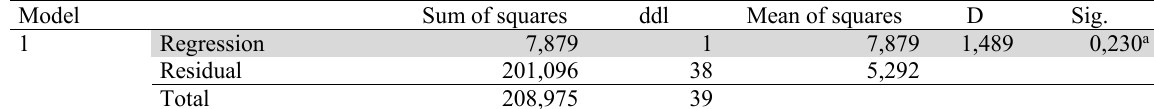
ANOVA b (Relation Aad → Ab) Model